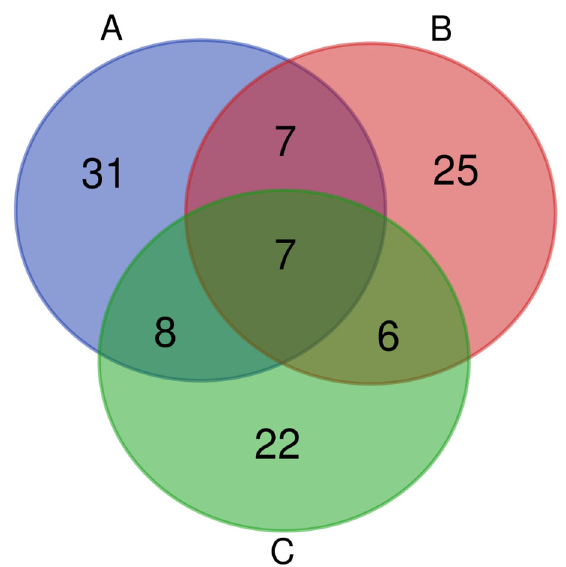
Figure 9. Comparison of genus-level bacteria detected by different methods in fermented grains. ( A ) Culturomics, ( B ) amplicon sequencing, ( C ) traditional culture technology.